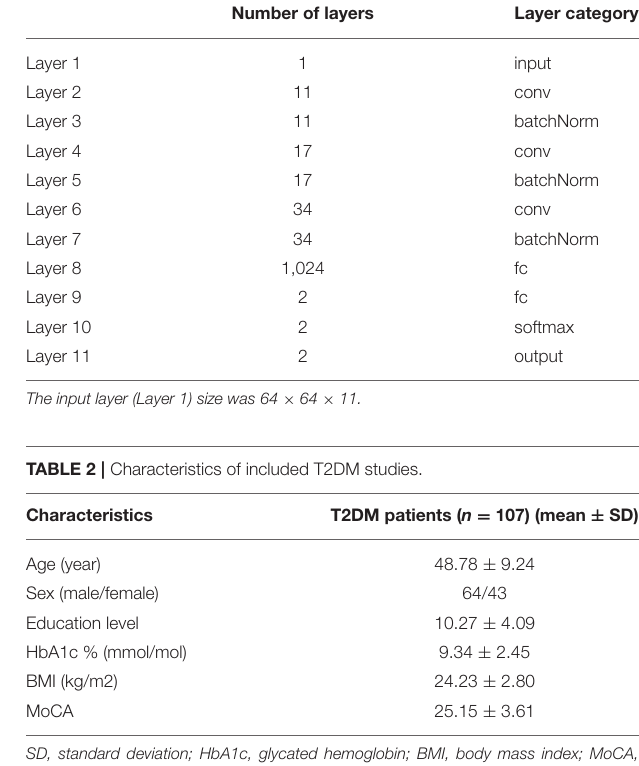
TABLE 1 | The information on the 11-layer 3D CNN. Number of layers